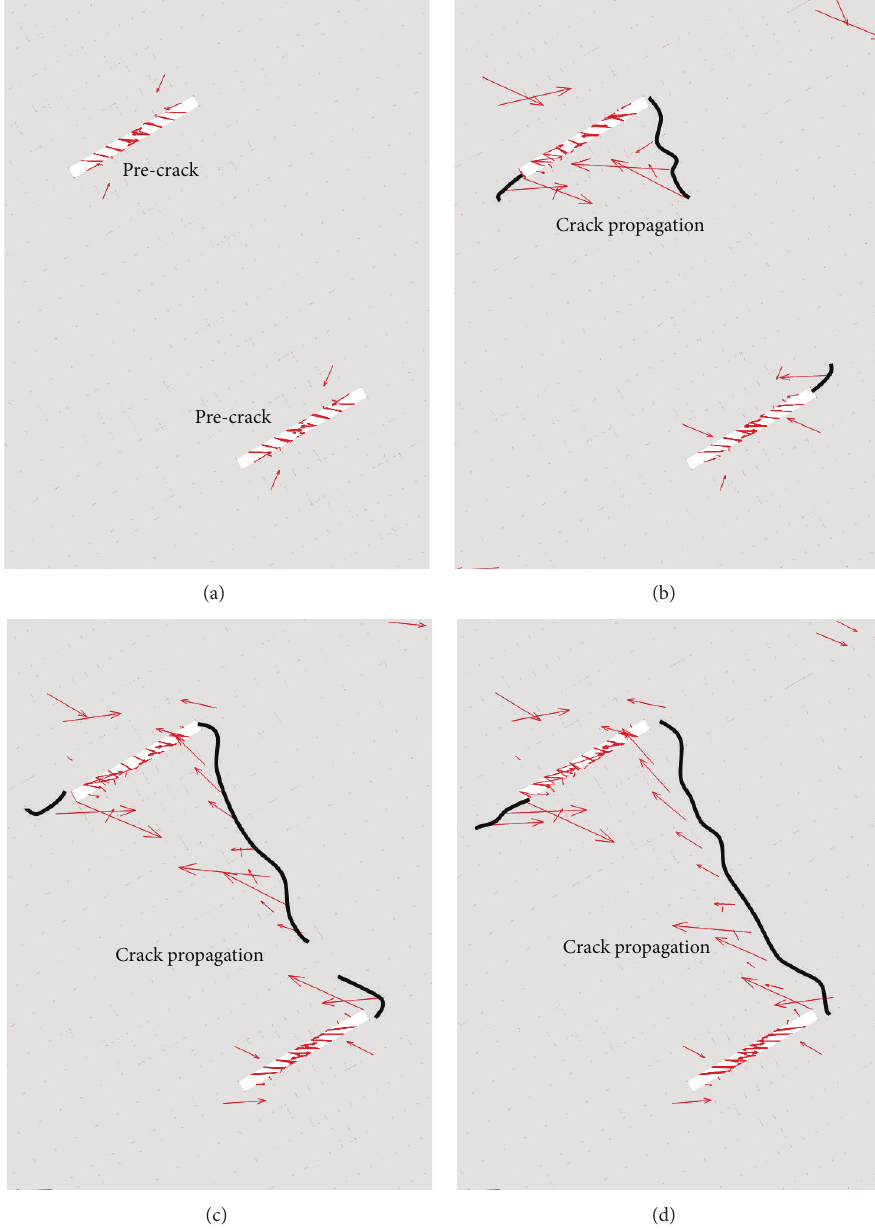
Figure 6: Unbalanced force evolution process at crack